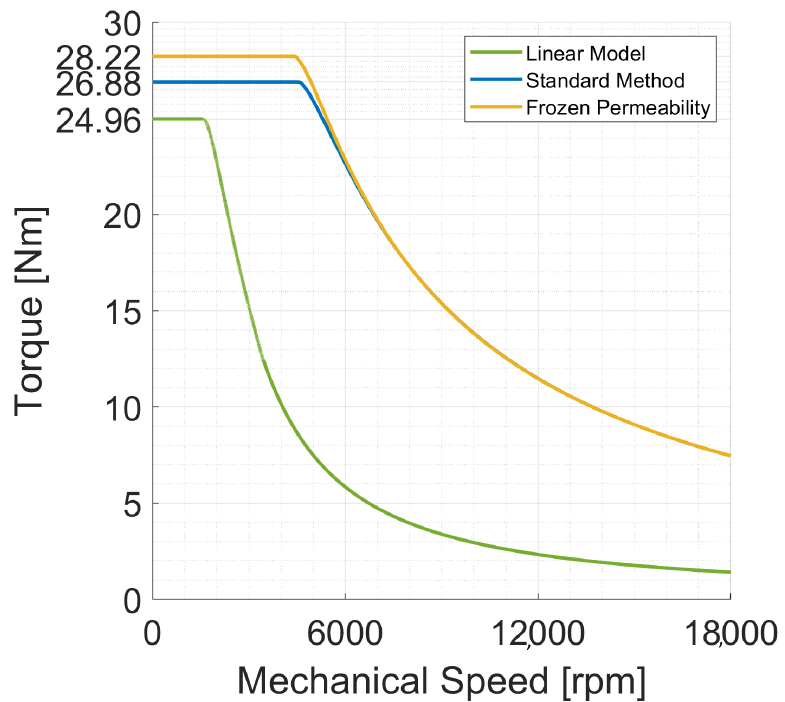
Figure 15. Comparison of torque–speed curves obtained by the conventional linear model, nonlinear model based on Standard Method and nonlinear model based on